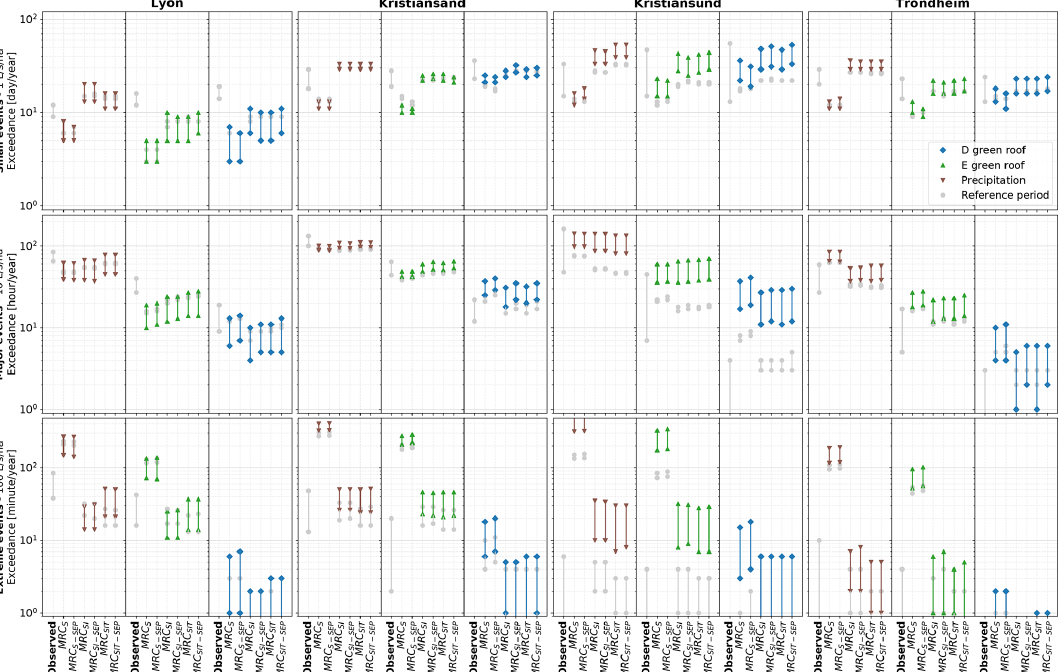
Figure C2. Future performance of green roofs (D and E) in Lyon, Kristiansand, Kristiansund and Trondheim; exceedance frequency for small events, major events and extreme events. The stochastic variability linked to the downscaled time series is evaluated with the 5th to 95th percentiles. Observed represents the fine-resolution observed time series or simulation using this time series as input. The 5th to 95th percentiles were estimated with a 3-year moving window. Due to log axis, occurrences lower than 10 0 are not